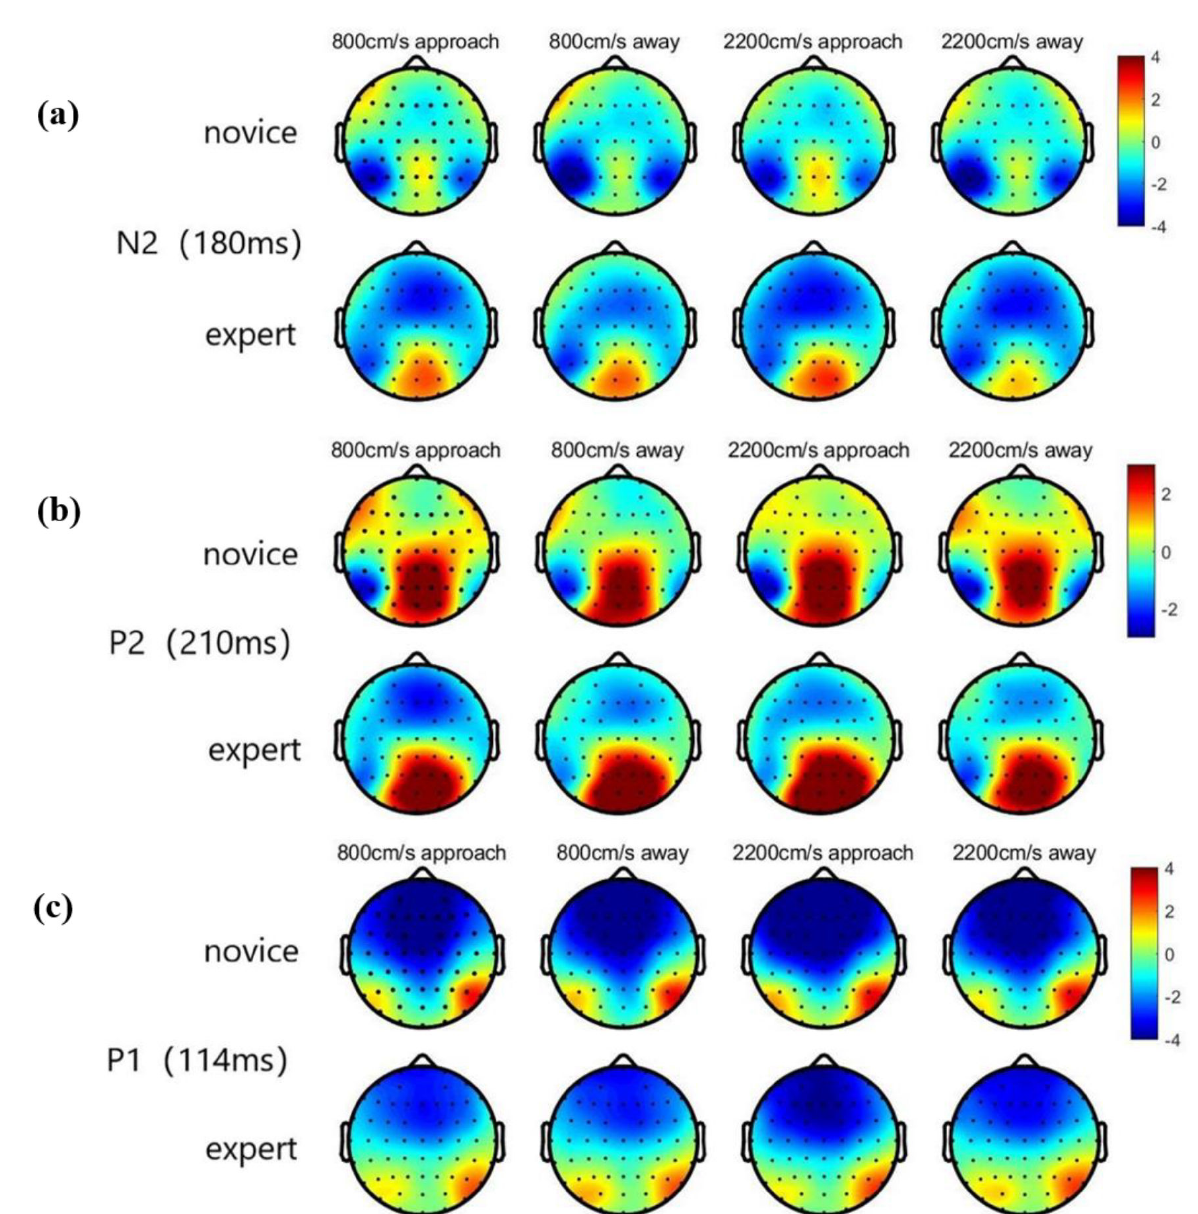
Figure 4. Instantaneous topographic maps of N2 (180 ms) ( a ), P2 (210 ms) ( b ), and P1 (114 ms) ( c ) under four experimental conditions. The topographic maps indicated the difference between novice and